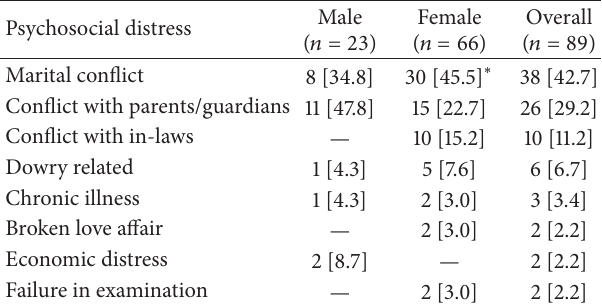
Table 3: Gender and cause of DSH (at first clinical contact). Psychosocial